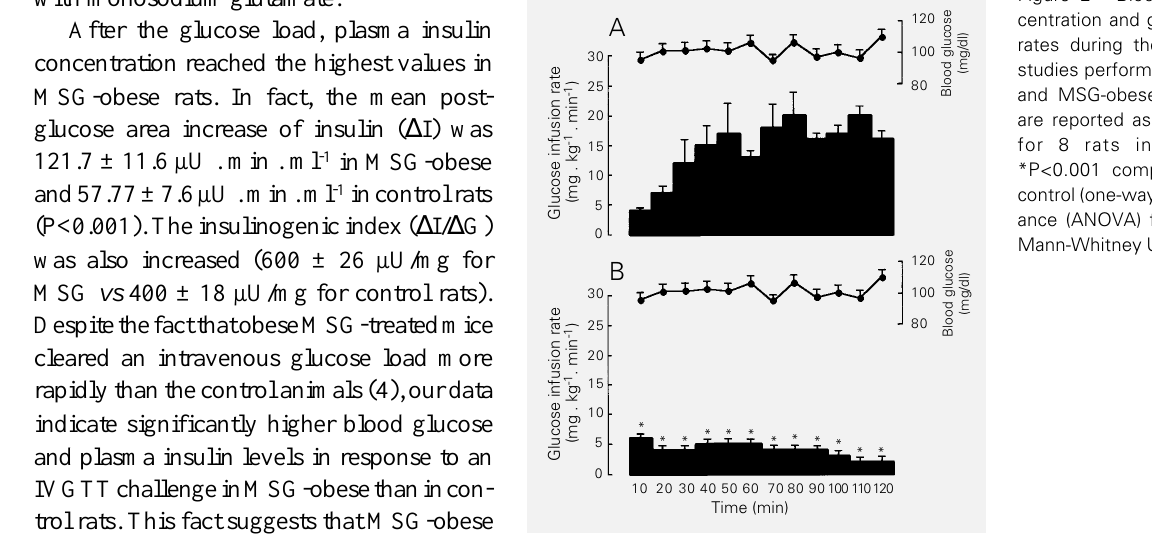
with monosodium glutamate. Figure 2 - Blood glucose con-